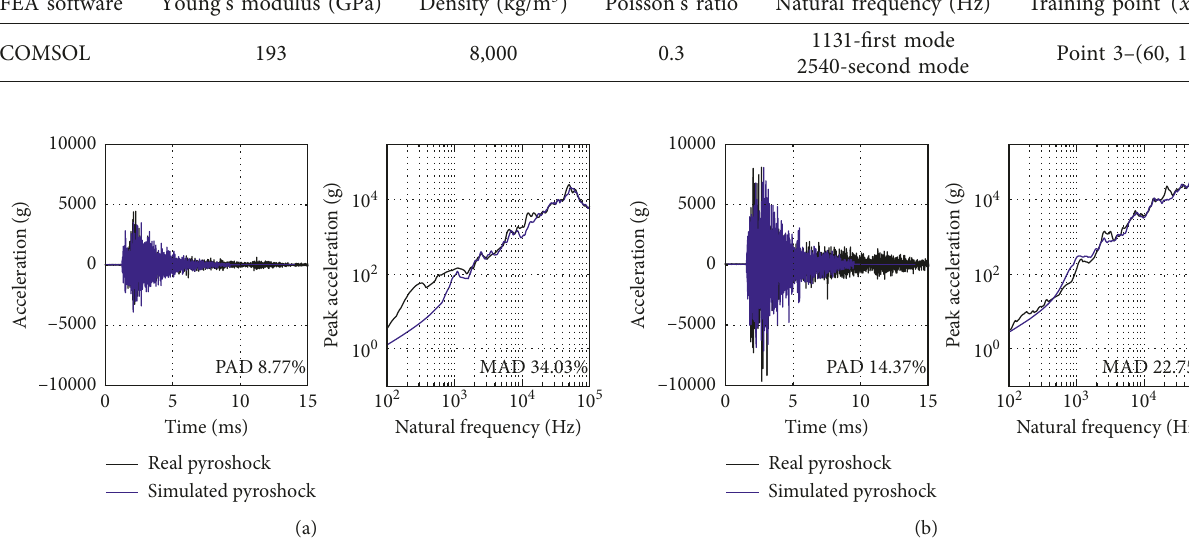
Figure 6: Simulation results of the 1/2-inch explosive bolt-induced shock at training points: (a) Point 1 and (b) Point 3.